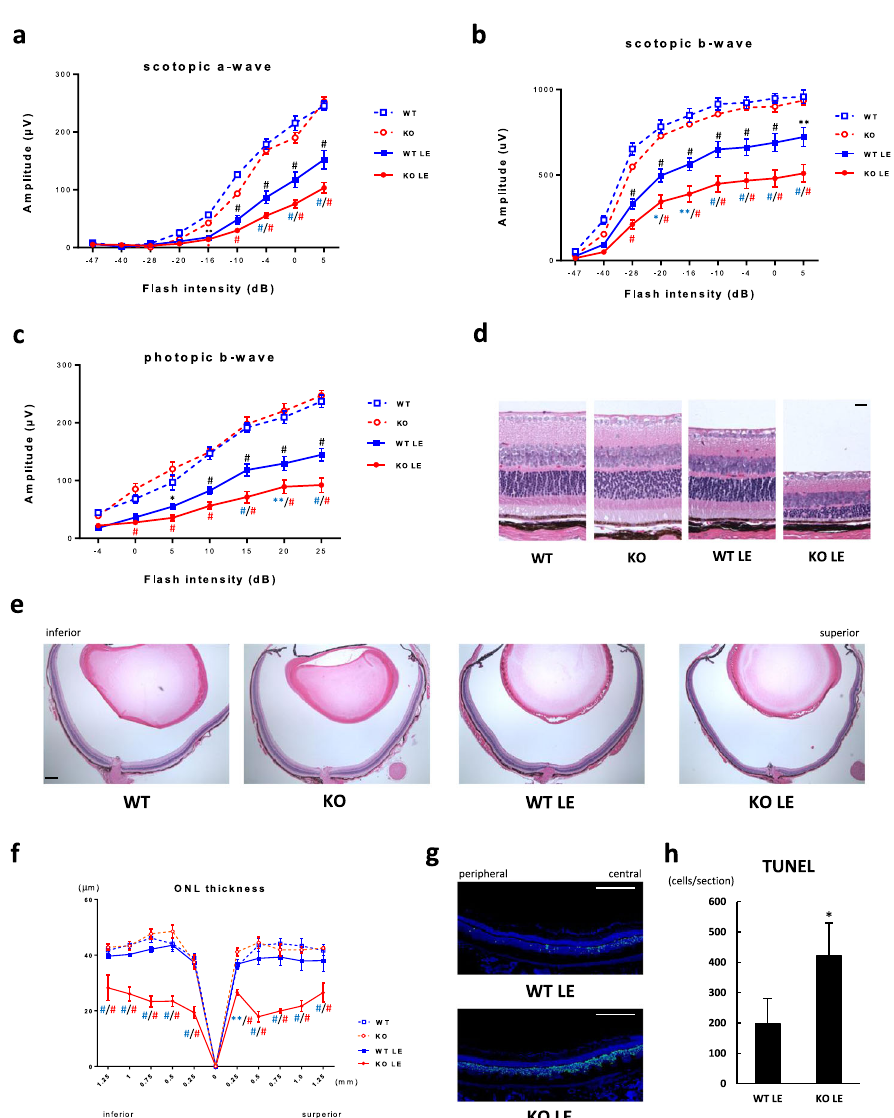
Fig. 4 SIRT3 KO retinas showed decreased retinal function and outer nuclear layer (ONL) thinning after the light exposure (LE). a – c Electroretinogram (ERG) of WT and SIRT3 KO retinas with 129 background without and with LE (4 days after LE; WT (blue square with dashed line): n = 4, KO (red circle with dashed line): n = 4, WT LE (blue square with solid line): n = 8, KO LE (red circle with solid line): n = 10) a Scotopic a-wave amplitude of WT and SIRT3 KO retinas with 129 background without and with LE. b Scotopic b-wave amplitude of WT and SIRT3 KO retinas with 129 background without and with LE. c Photonic b-wave amplitude of WT and SIRT3 KO retinas with 129 background without and with LE. * p < 0.05, ** p < 0.01, and # p < 0.001 by two-way ANOVA with post hoc Tukey ’ s HSD test (black: WT vs WT LE, blue: WT LE vs KO LE, red: KO vs KO LE). d , e Representative HE staining images of WT and SIRT3 KO retinas with 129 background without and with LE (7 days after LE). Scale bars: d 20 μ m e 200 μ m. f Outer nuclear layer (ONL) thickness of WT and SIRT3 KO retinas with 129 background without and with LE (7 days after LE; WT (blue square with dashed line): n = 4, KO (red circle with dashed line): n = 4, WT LE (blue square with solid line): n = 4, KO LE (red circle with solid line): n = 5). * p < 0.05, ** p < 0.01, and # p < 0.001 by two-way ANOVA with post hoc Tukey ’ s HSD test (blue: WT LE vs KO LE, red: KO vs KO LE). g Representative images of terminal deoxynucleotidyl transferase dUTP nick end labeling (TUNEL) stain for WT and SIRT3 KO retinas with 129 background 36 h after LE. Blue: DAPI, Green: TUNEL. Scale bars: 250 μ m. h Comparison of TUNEL-positive cell counts per section ( n = 6 for WT LE and n = 4 for KO LE). * p < 0.05 by two-tailed unpaired t -test. Values are mean ± SE for ERG analysis, and mean ± SD for ONL thickness and TUNEL analysis,